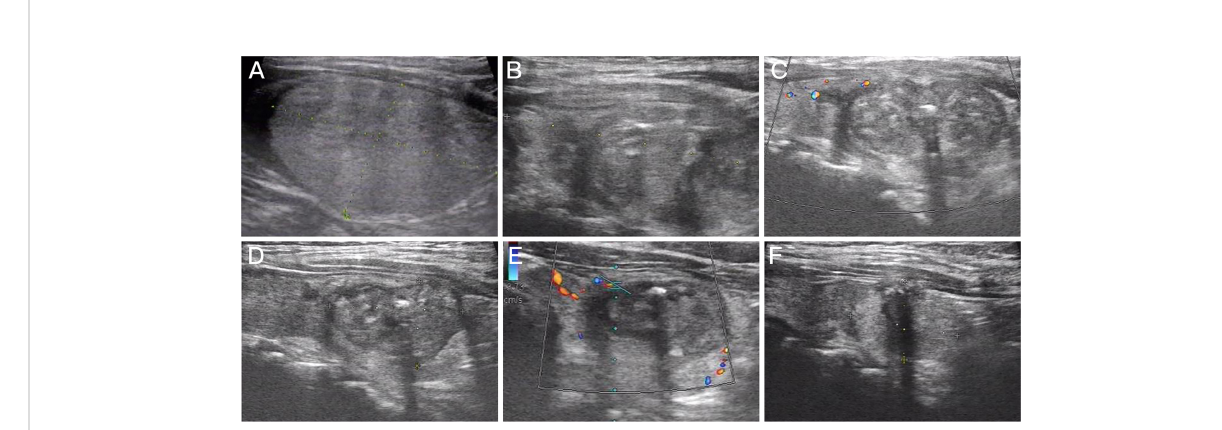
FIGURE 3 Imaging of a 63-year-old woman with Bethesda IV nodules who underwent microwave ablation (MWA). (A) An isoechoic solid thyroid nodule was detected in the left lobe with an initial volume of 14.29 ml. (B) Ultrasound examination showed enlarged ablation area (20.16 ml) immediately after MWA. (C – F) The volume of the ablation area was 12.39, 6.33, 3.13, and 2.04 ml at 1, 3, 6, and 12 months after MWA, respectively.